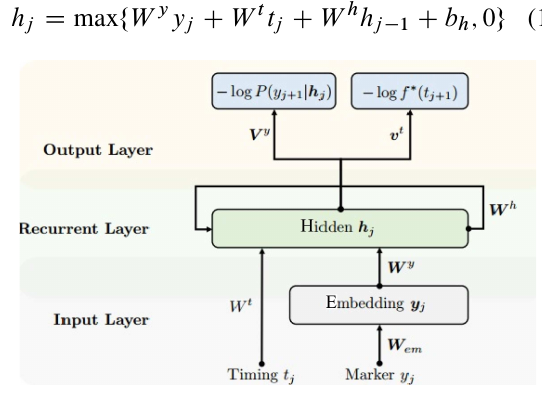
Fig. 16 RMTPP framework [63]